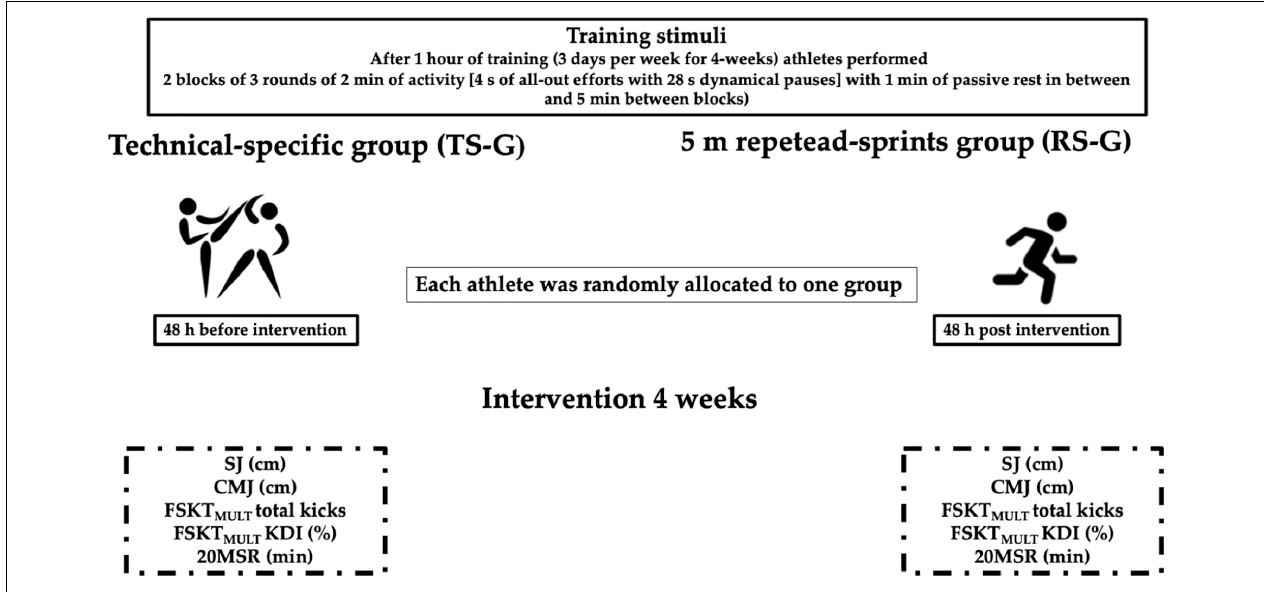
FIGURE 2 | High-intensity interval training with specific techniques (HIIT TS-G) vs. HIIT with repeated sprints (HIIT RS-G) training program. SJ, squat jump; CMJ, countermovement jump; FSKT MULT , multiple frequency speed of kick test; KDI, Kick Decrement Index; 20MSR, 20-m shuttle run